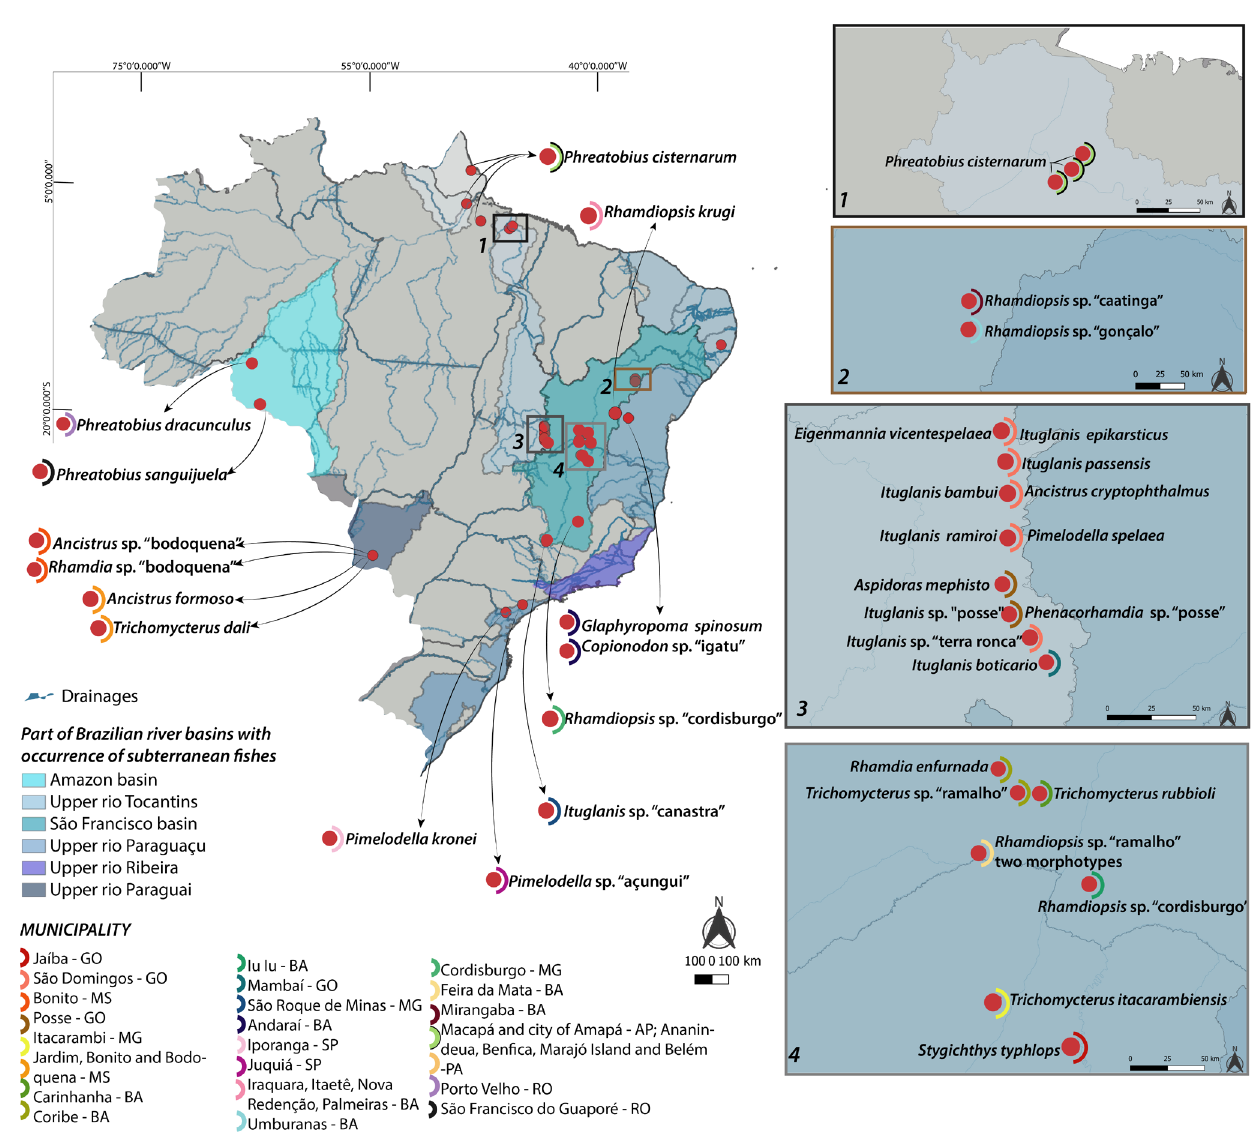
FIGURE 1 | Map of Brazil showing the distribution of the subterranean fish species according to the basins included in the country’s